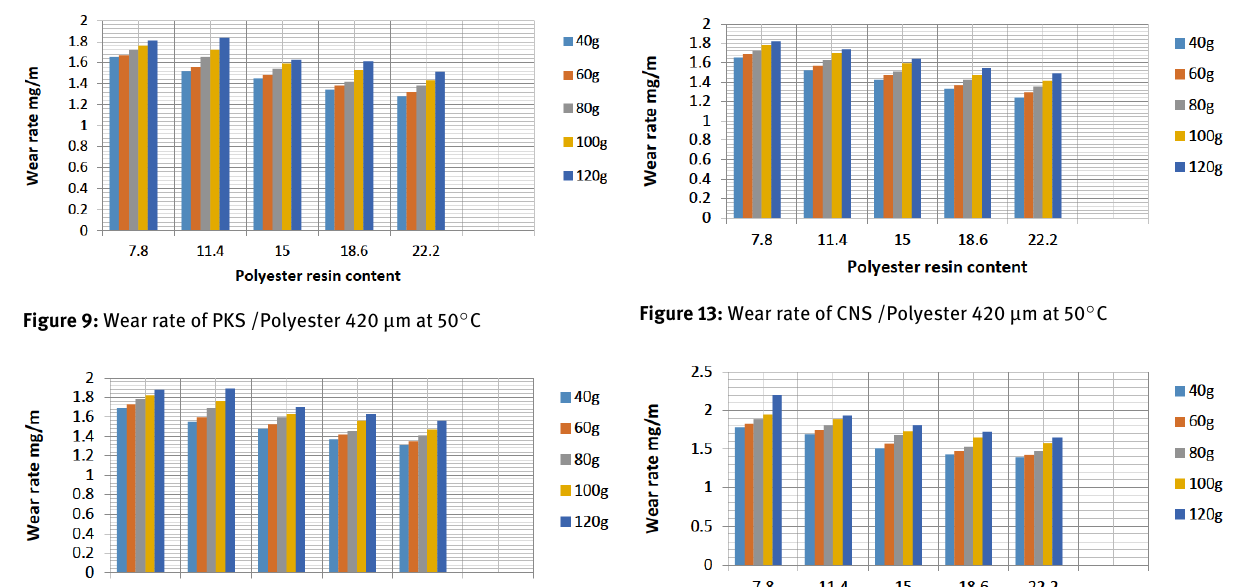
Figure 10: Wear rate of PKS /Polyester 420 µ m at 150 ∘ C